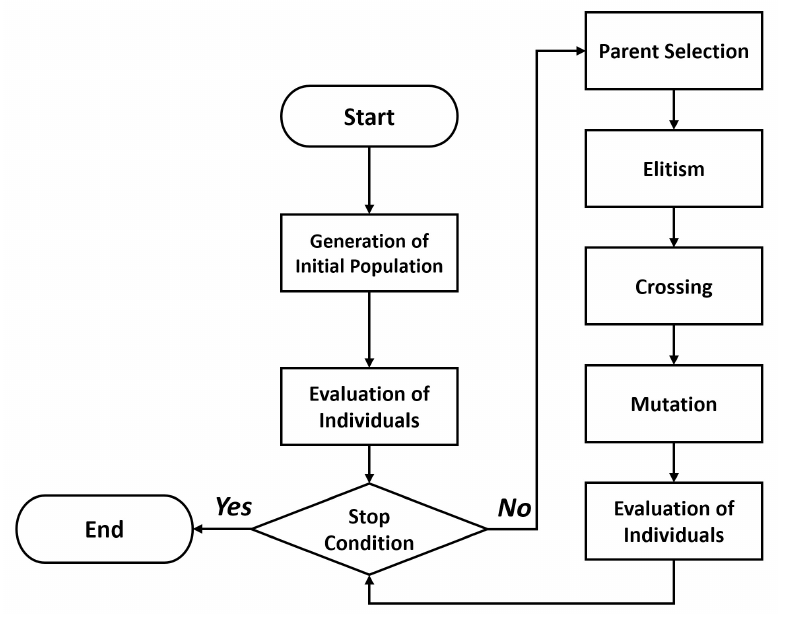
Figure 2. Flux Diagram of a Genetic Algorithm (GA).